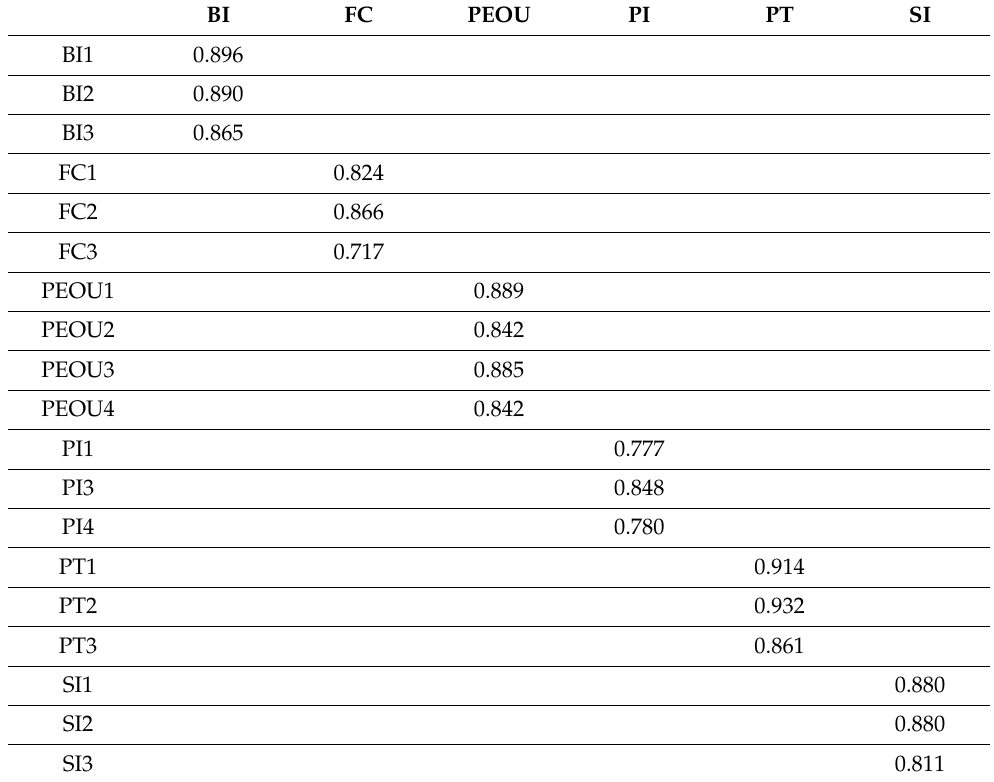
Table 2. Outer loading values.